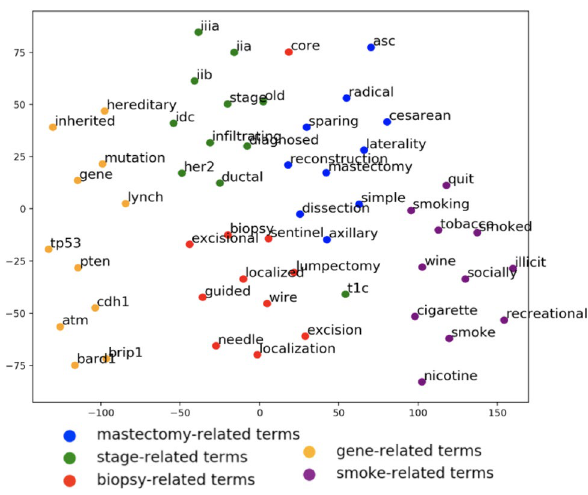
Figure 1. 2D visualization of word embeddings computed using t-SNE 16